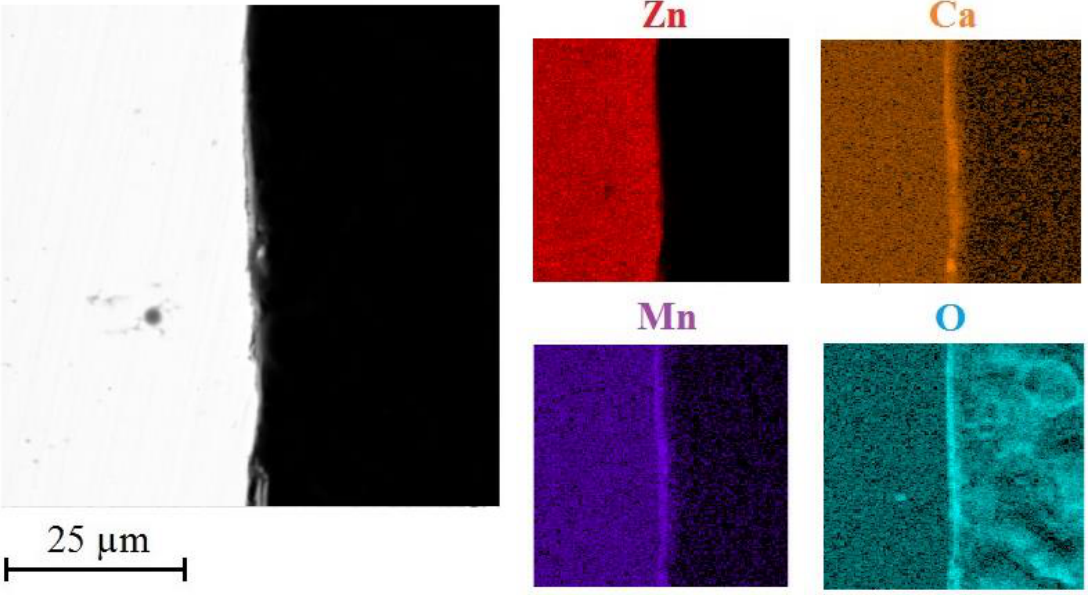
Figure 25. SEM—distribution of Zn/Ca/Mn/O on cross section in precipitate of corrosion products (exposure in simulated concrete pore solution with KMnO 4 (Mn (3) )).